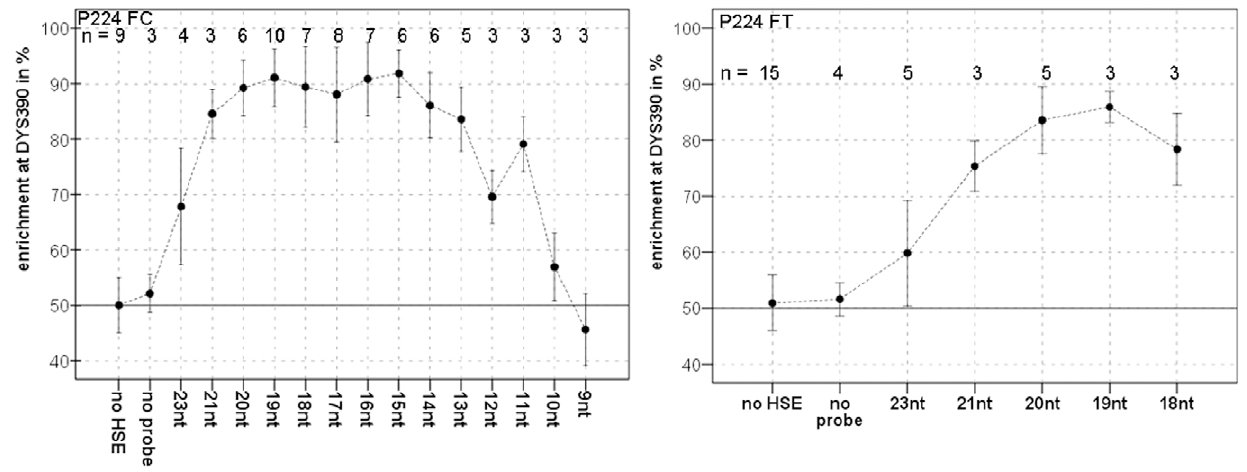
Figure 4. Separation by HSE with different probes. Enrichment of one contributor from a male DNA mixture is shown in relation to probe length for two different probe sets P224FC/FT (see also File S2). The bars indicate standard deviation of the mean enrichment. No HSE indicates analysis of the male DNA mixture without separation by HSE, and no probe indicates separation of a male DNA mixture by HSE without probe. n = number of